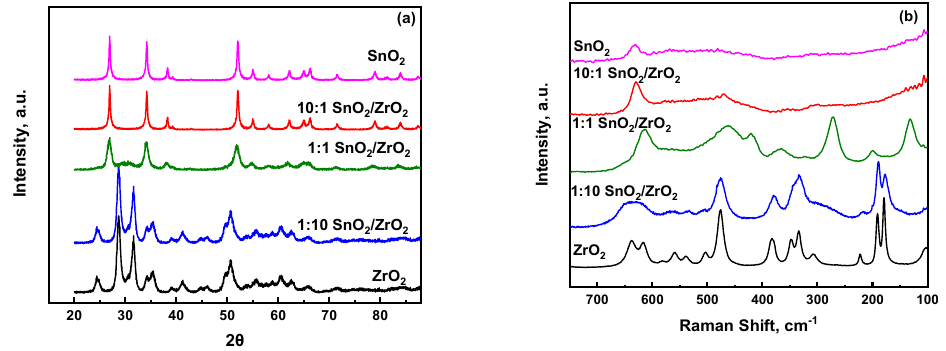
Figure 1. ( a ) X-ray diffraction patterns and ( b ) ambient temperature Raman spectra of non-sulfated single as well as mixed SnO 2 /ZrO 2 oxides.